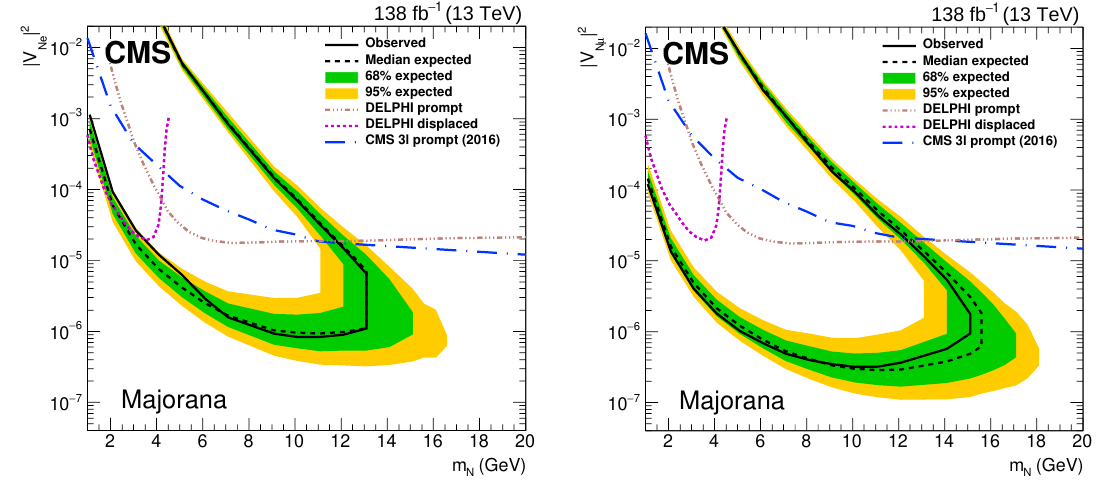
for a Majorana | 2 (left) and | V | 2 (right) as functions of m Ne N m N